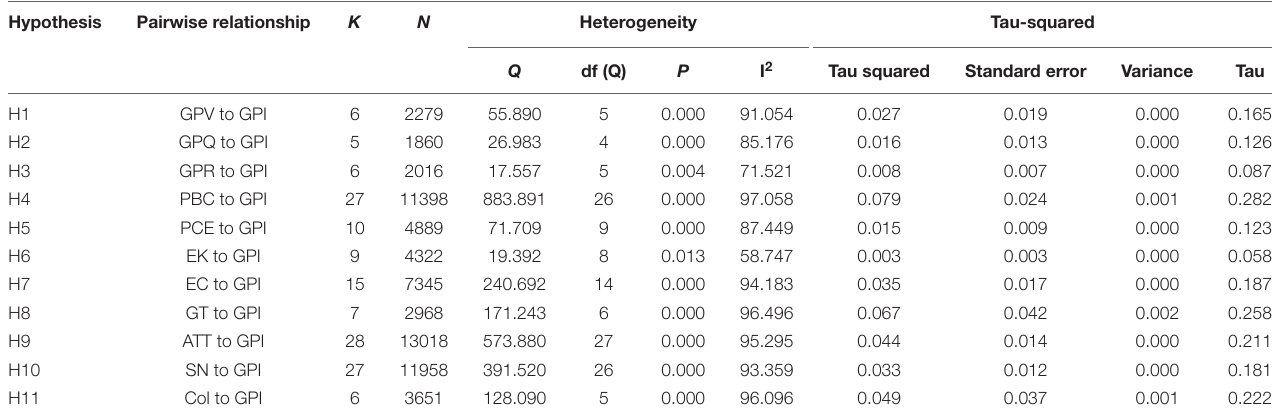
FIGURE 3 | Funnel plot. TABLE 4 | Heterogeneity